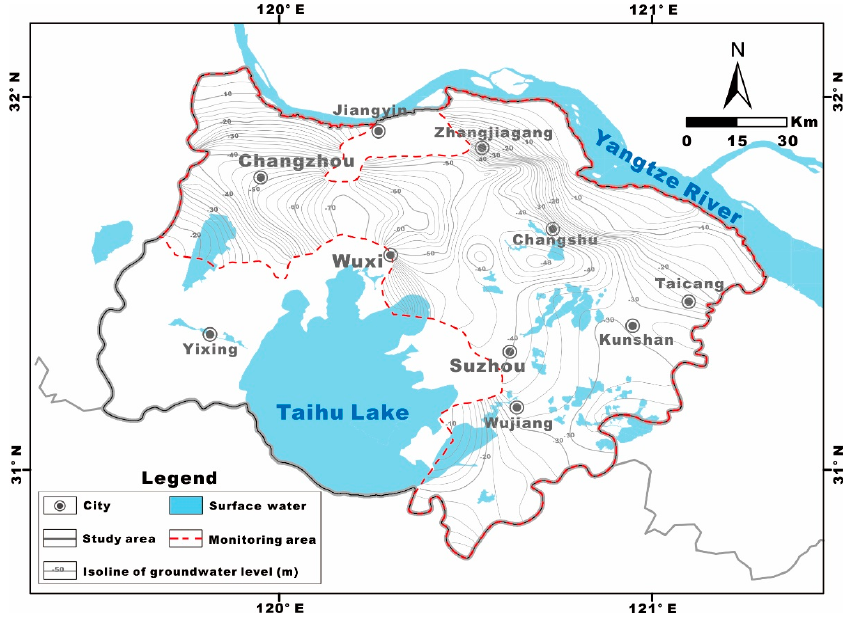
Figure 7. Contour plot of the groundwater table in the Su-Xi-Chang region (2015).